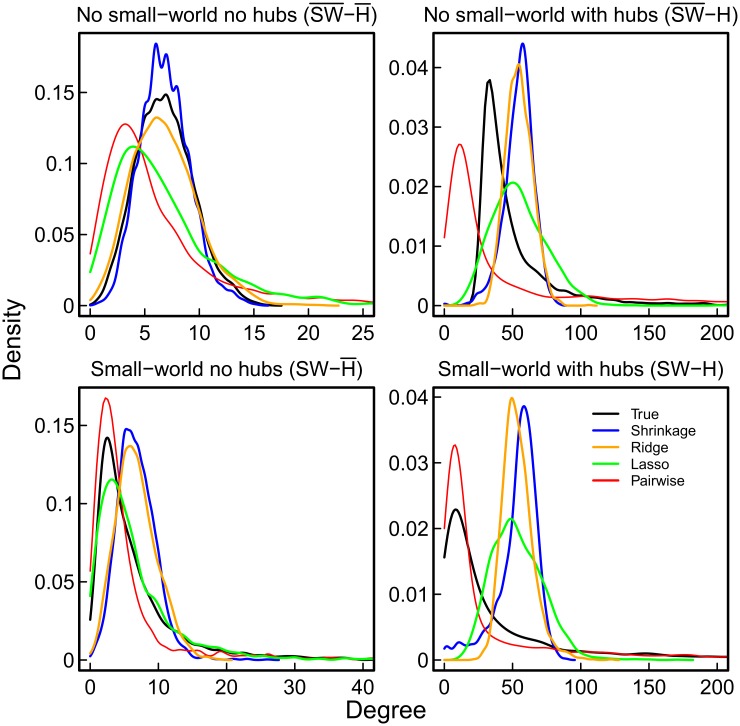
Recovery of degree distributions based on 500 observations.Densities of the true (black) and recovered node degrees of shrinkage (blue), ridge (orange), and lasso (green) estimated partial correlations, and of pairwise correlations (red). NB: x-axis cut off.